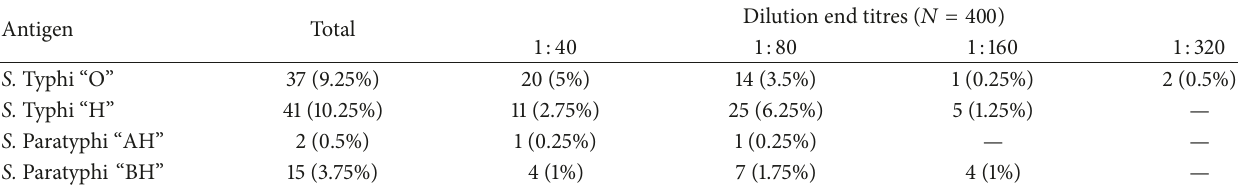
Table 3: Comparison of frequency and percentage of baseline antibody titres against different serotypes of Salmonella enterica . Antigen